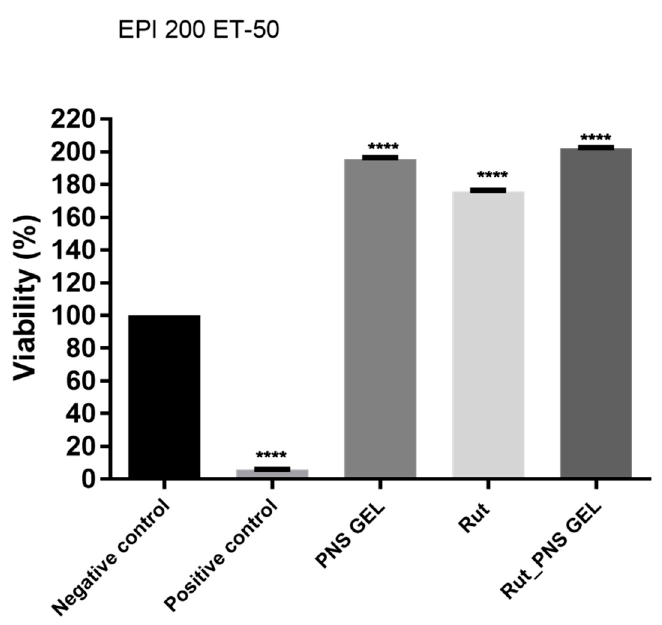
Figure 5. Viability percentage of EpiDerm skin model inserts (EPI 200 ET-50) at 18 h with the test samples (proniosomal control gel, rutin and proniosomal rutin gel). One-way analysis of variance (ANOVA) followed by Tukey’s post-test was applied to determine the statistical differences between sample-treated inserts vs. negative control-treated inserts ( p < 0.0001 indicated by ****). Positive control is represented by Triton X-100 1%, and Milli-Q H 2 O was used as negative